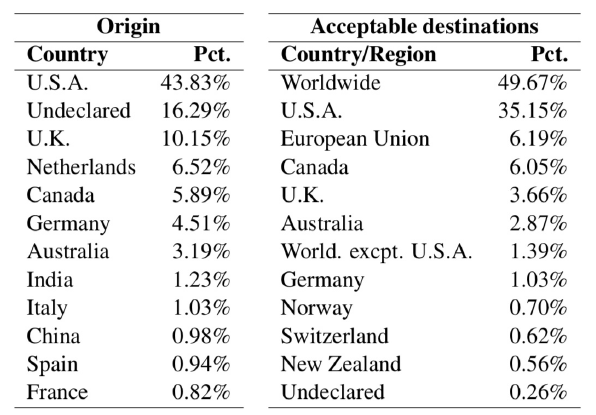
FIGURE 1 | Shipping origin and destination (Christin, fn 14, at